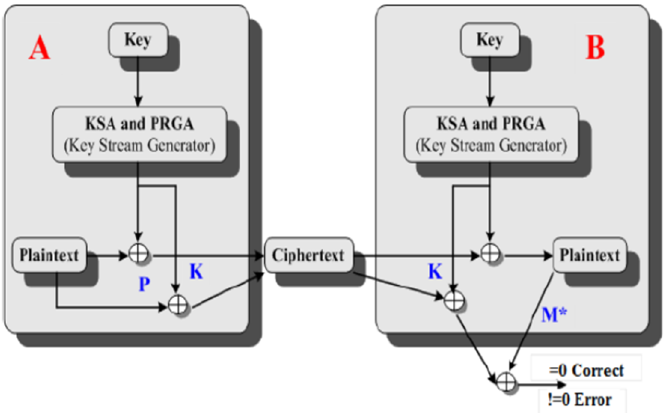
Figure 1. Conventional Fault Tolerance